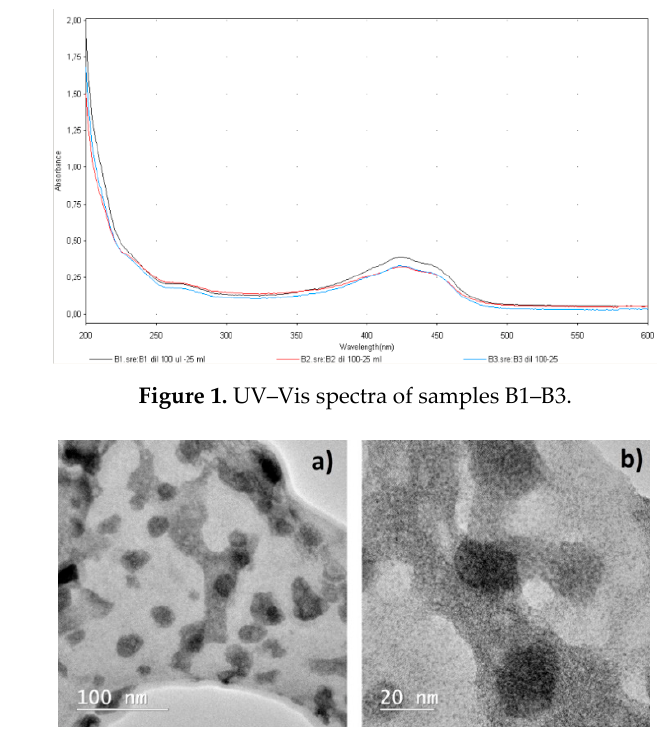
Figure 2. TEM images of particles ( a ) B2 and ( b )